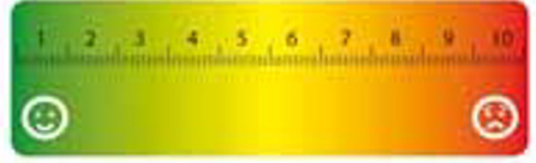
Figure 1. Visual Analogue Scale -